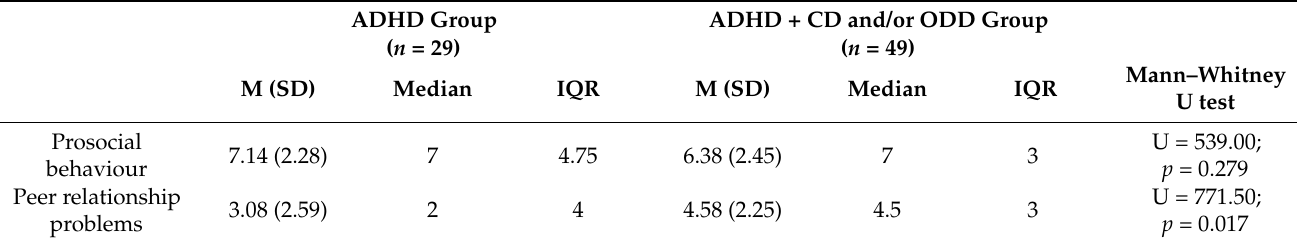
Table 6. Prosocial behaviour and peer relationship problems among children diagnosed with ADHD and among children diagnosed with ADHD and externalizing comorbid diagnoses. ADHD Group ADHD + CD and/or ODD Group ( n = 29) ( n = 49) Mann–Whitney M (SD) Median IQR M (SD) Median IQR U test Prosocial U = 539.00; 7.14 (2.28) 7 4.75 6.38 (2.45) 7 3 p = 0.279 behaviour Peer relationship 3.08 (2.59) 4.58 (2.25) problems